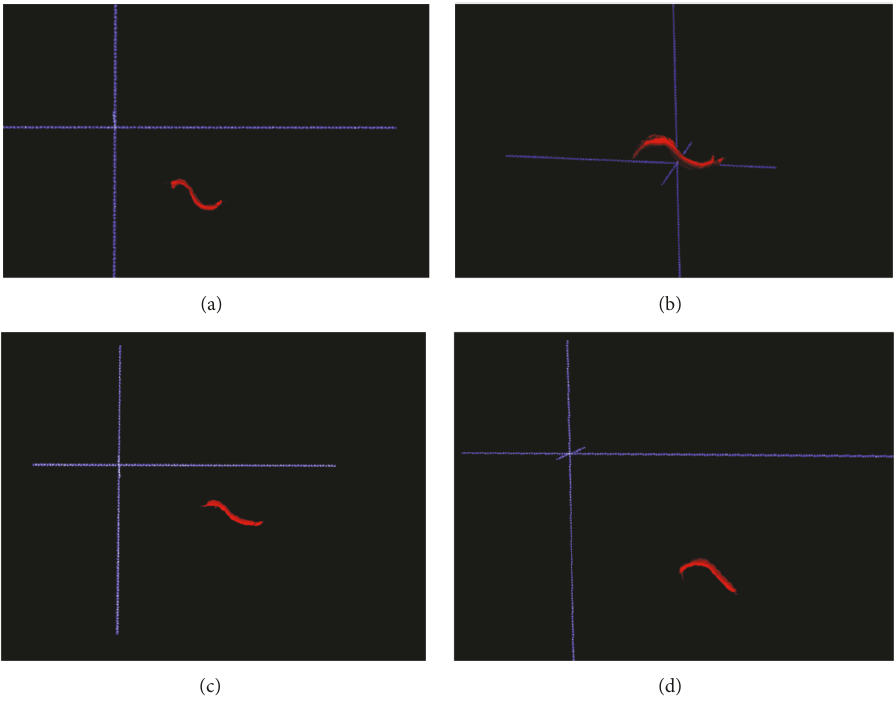
Figure 2: 3D reconstruction of the articular eminence characterizing it as (a) box, (b) sigmoid, (c) flattened, and (d) deformed.